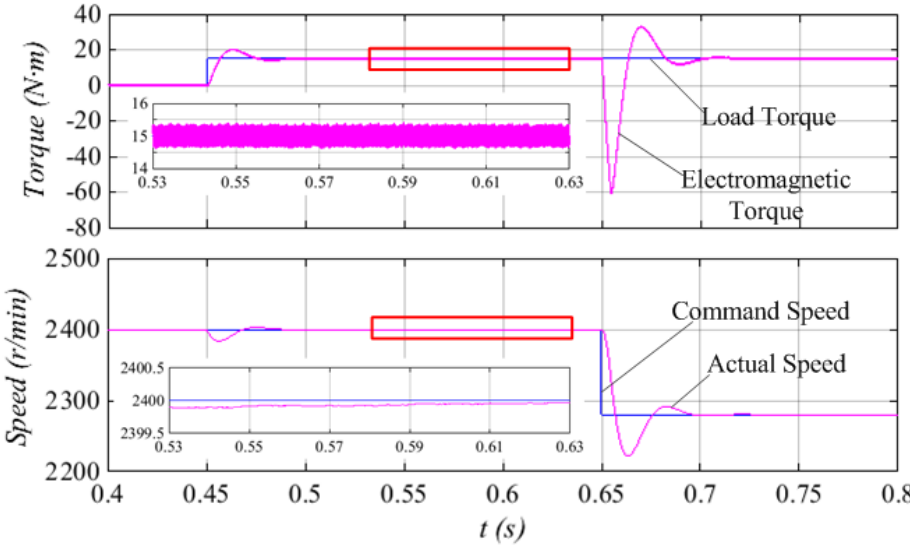
Figure 11. Simulation results of electromagnetic torque T e and rotor speed n for the DZIPWM.